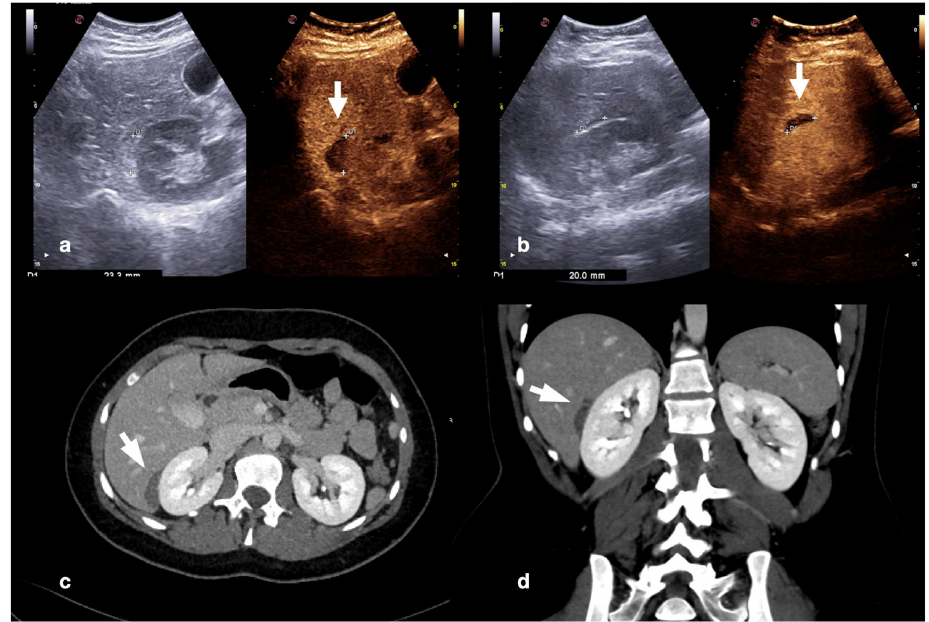
Figure 23. Sub-Glissonian hepatic hematoma in a 40−year-old woman. At B-mode US study ( a , b , split image on the left), no definite hematomas was showed. At CEUS evaluation ( a , b , split image on the right), the presence of a small sub-Glissonian hematoma was clearly delineated (arrow). Contrast-enhanced CT examination ( c , axial and d , coronal view) confirmed the presence of the small non-bleeding sub-Glissonian hematoma (arrow).